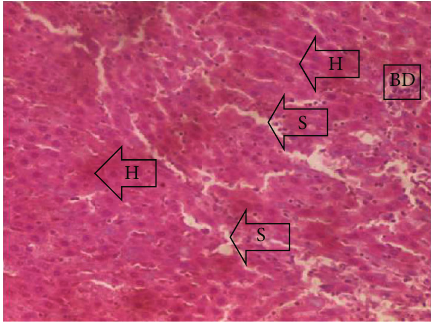
Figure 3: Photomicrographs of the group III rats showing normal liver of intact hepatocytes, sinusoids containing Kup ff er cells, and congested capillaries.